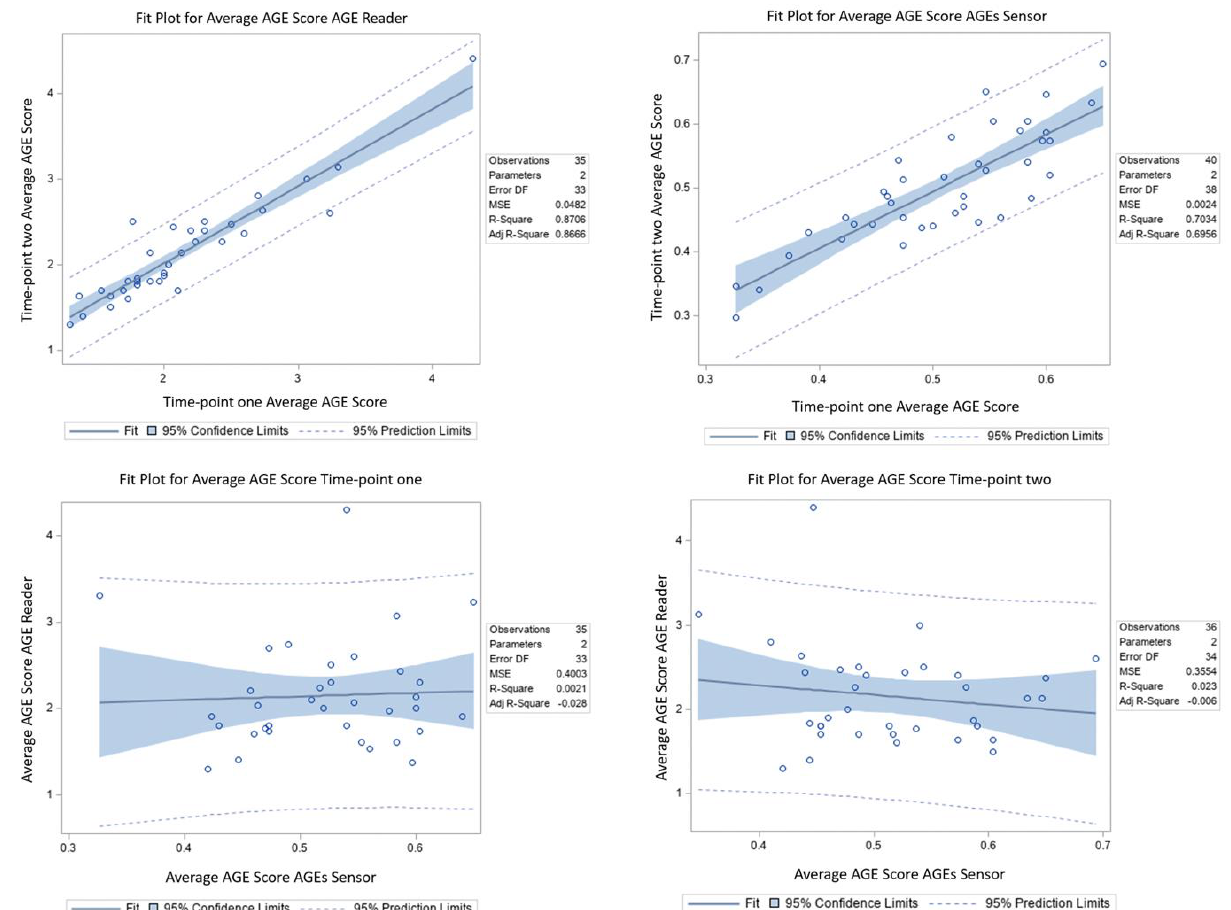
Figure 1. Correlation plots within ( top ) and between ( bottom ) AGE reader and AGE sensor.